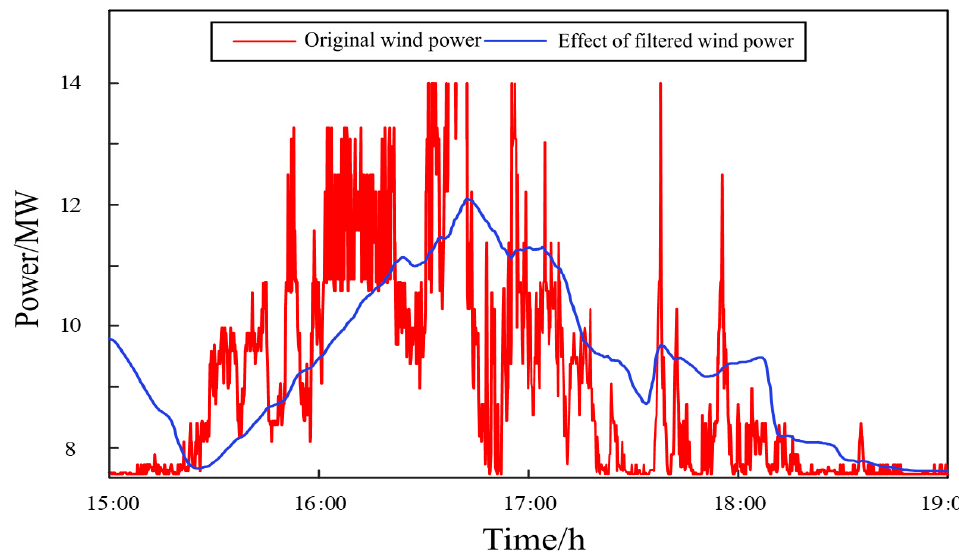
Figure 12. Wind power stabilization effect without stratified control.